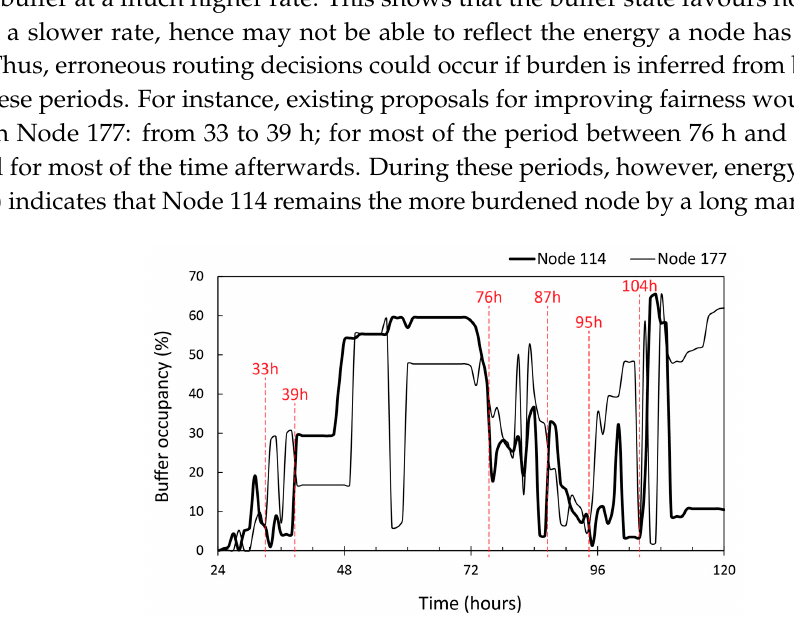
Figure 19. Buffer occupancy against time for Node 114 and 177.